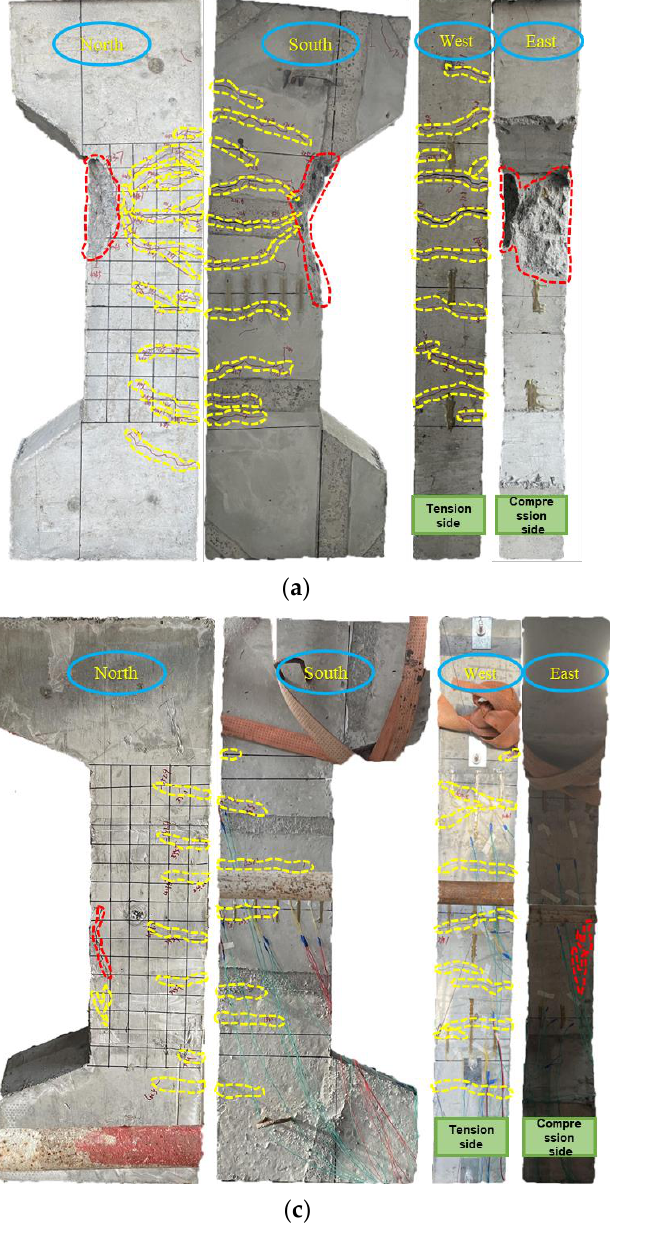
( b ) Figure 9. Load–maximum crack width curves of RC columns: ( a ) e 0 / h 0 = 0.60; ( b ) e 0 / h 0 = 0.70. 3.2. Load–Deflection Relationships Figure 10 shows the axial load–deflection relationship (axial and lateral displace- ments) of RC columns under large eccentric loads. Axial and lateral displacements were measured using a vertical displacement gauge and a displacement gauge at the midspan point along the column depth, respectively. The negative and positive values in the figure indicate the axial and lateral displacements, respectively, at the midspan point along the